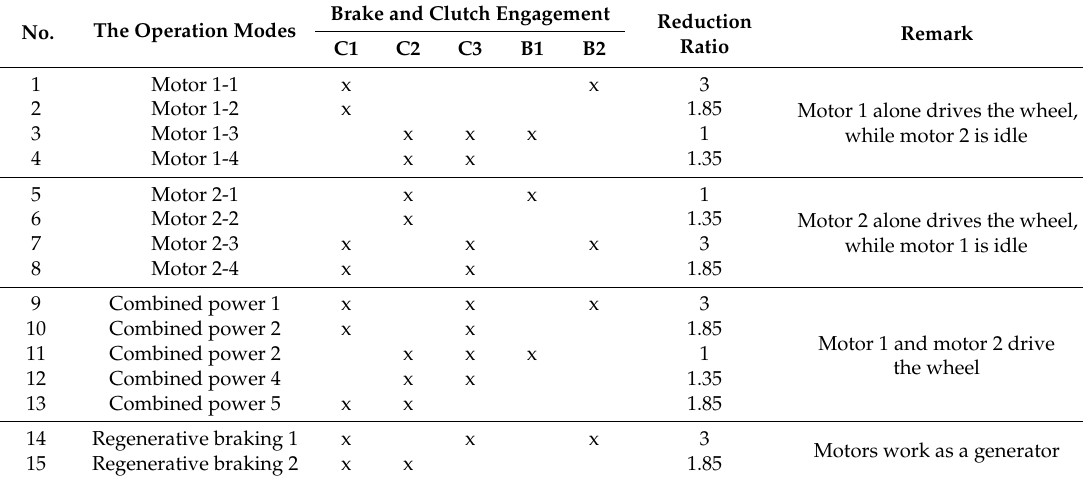
Table 1. The clutching conditions and the operation modes.